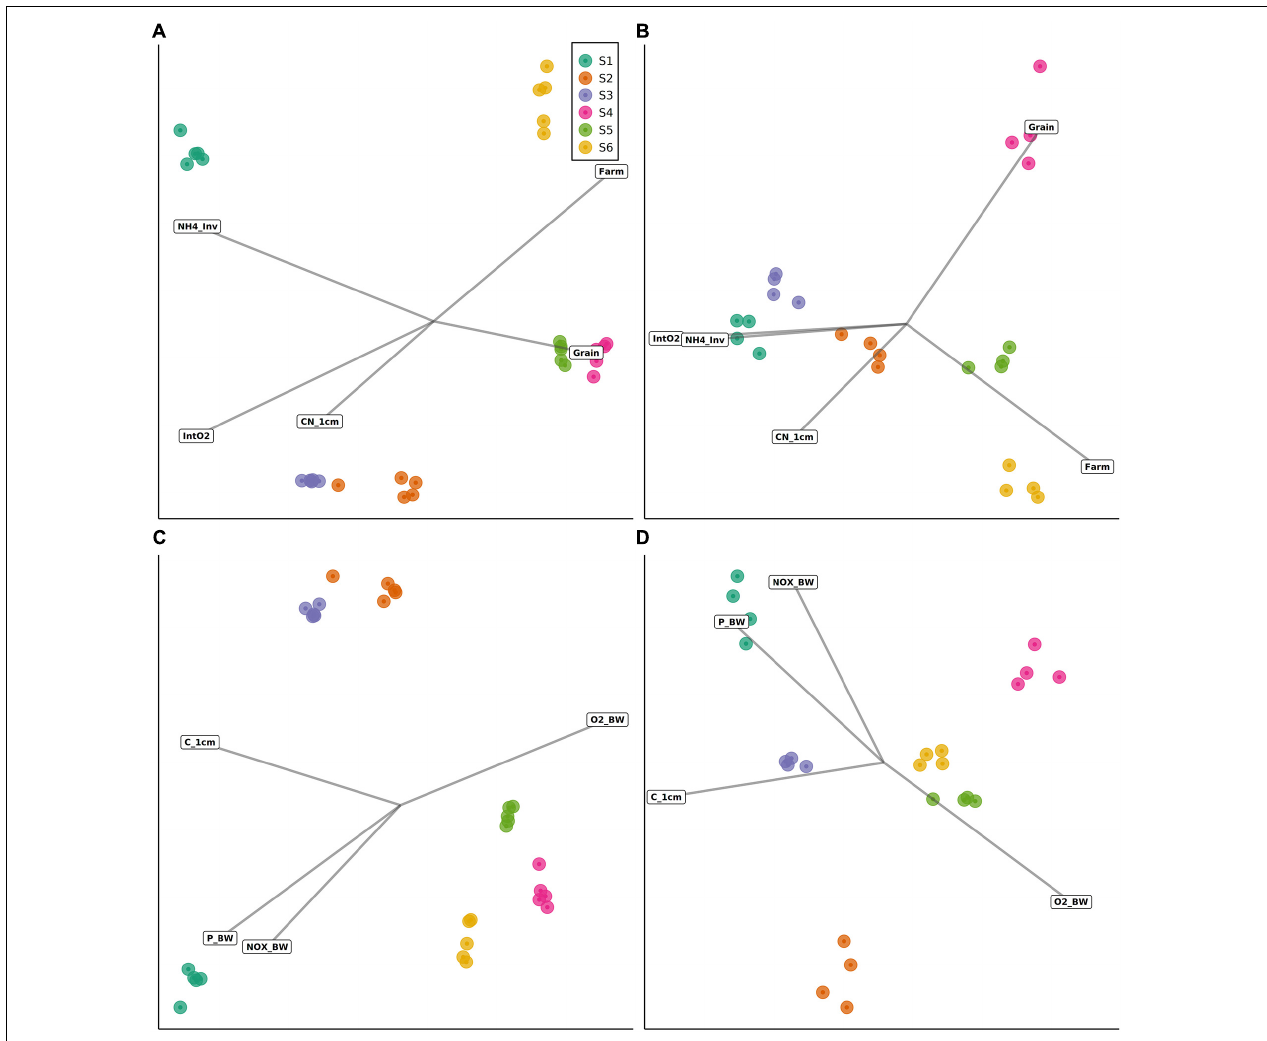
FIGURE 7 | Distance-based redundancy analyses (db-RDA) of sediment bacterial and eukaryotic communities, based on two types of models (see Table 4 for details). Data are shown for (A) bacterial communities (Model 1), (B) eukaryotic communities (Model 1), (C) bacterial communities (Model 2) and (D) eukaryotic communities (Model 2). Environmental variables were projected onto the ordination space using the R function envfit() fitted on linear scores of the ordination